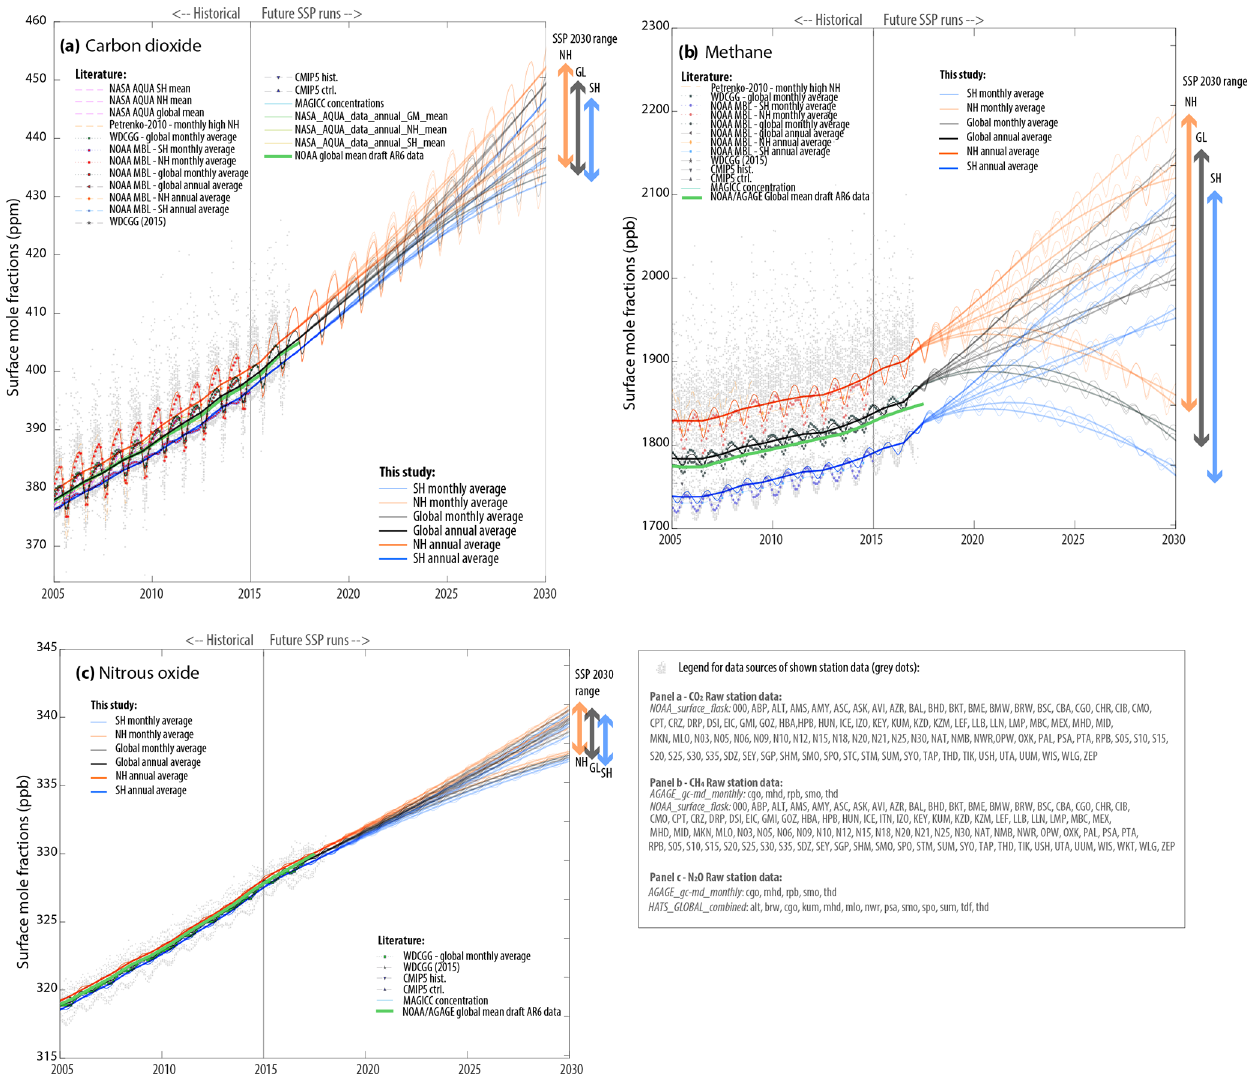
Figure 6. Transition between historical runs and future SSP concentrations for CO 2 (a) , CH 4 (b) , and N 2 O (c) surface mole fractions. The observational in situ and flask station data points reach into the first years of the future SSP datasets (grey dots). Derived northern hemispheric (orange), global (black), and southern hemispheric averages (blue) are shown with annual averages (thick lines) and monthly averages (thin lines with seasonality variability). On the right axis side, the illustrative arrows indicate the min–max range across the scenarios for northern hemispheric, global, and southern hemispheric annual-average concentrations by 2030 across all nine SSP scenarios. The NOAA/AGAGE global mean data series are shown in green. For a description of labels of other comparison data, see Table 12 in Meinshausen et al.